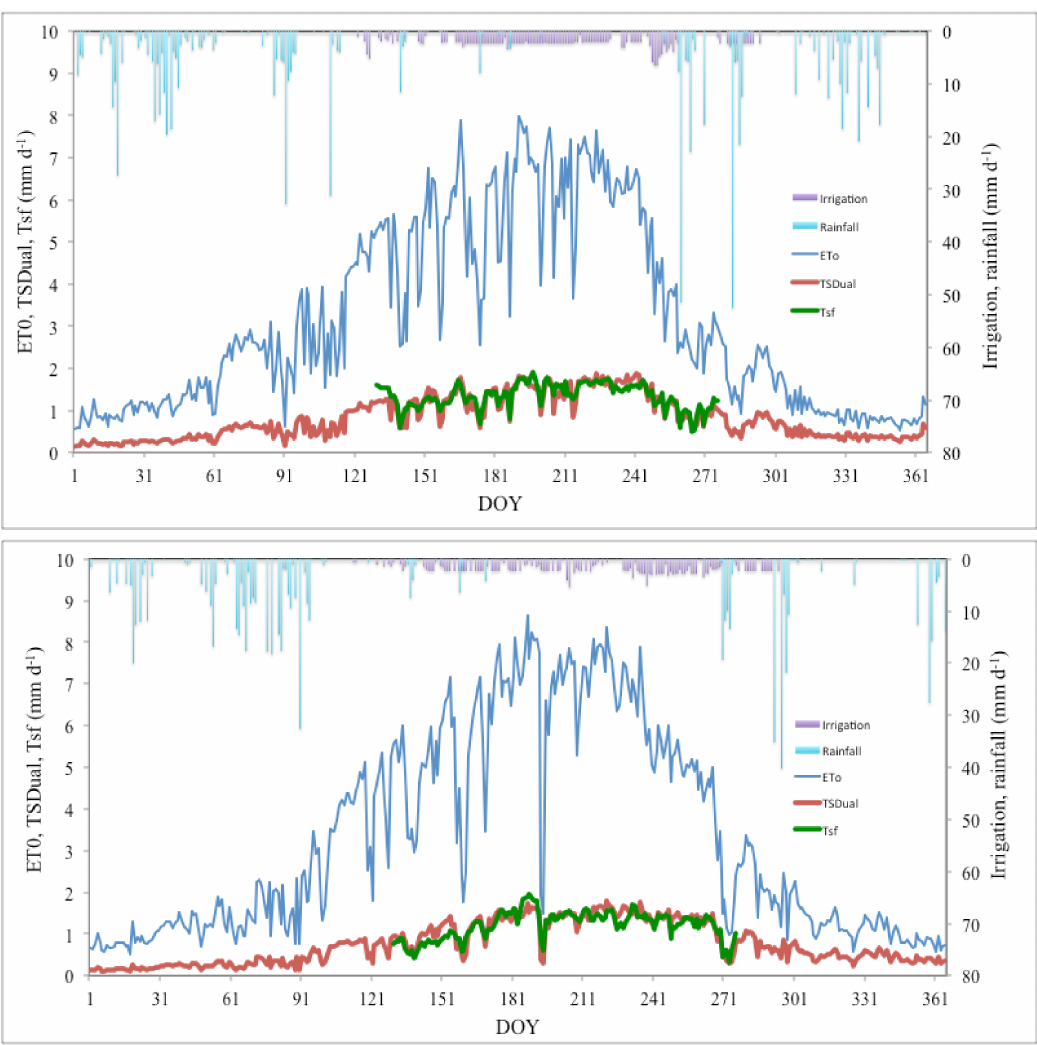
Figure 2. Crop transpiration modeled with SIMDualKc ( T SDual ), calibrated transpiration derived from sap-flow data ( T sf ), reference evapotranspiration ( ET o ), and irrigation and rainfall amounts for 2014 (upper panel) and 2013 (lower